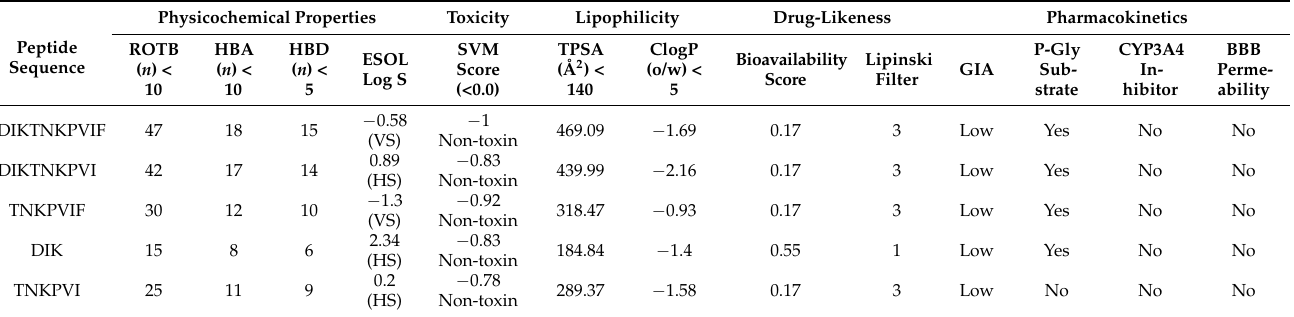
Table 2. Absorption, distribution, metabolism, excretion and toxicity (ADME/Tox) profile for anti-inflammatory decapeptide and its fragments to predict drug-likeness and suitability for human